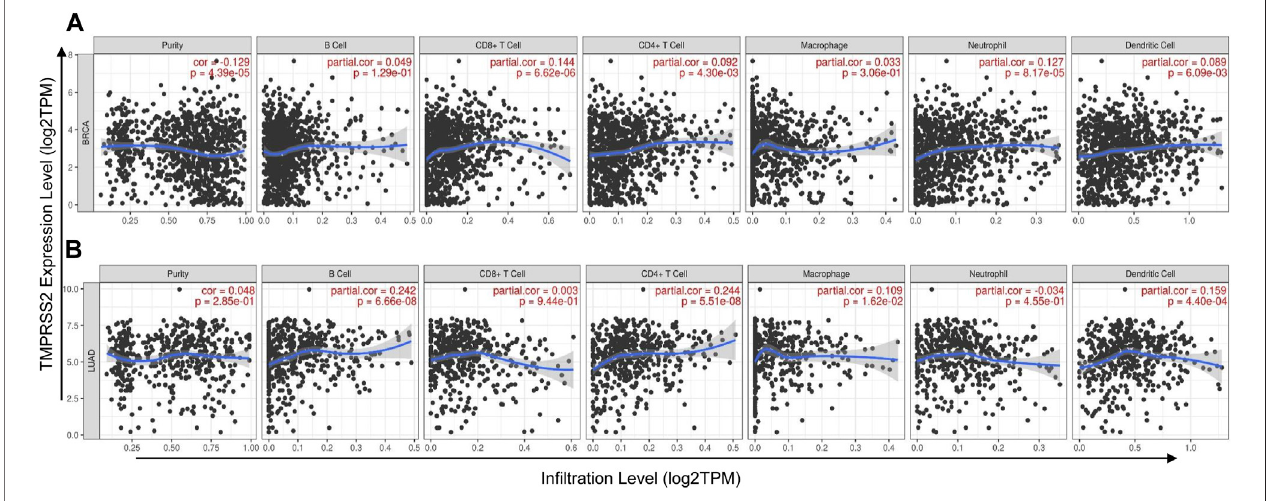
FIGURE 3 | Correlation of TMPRSS2 expression with immune cells in fi ltration level in BRCA (breast invasive carcinoma) and LUAD (lung adenocarcinoma) were detected by TIMER. (A) TMPRSS2 expression is positively correlated with in fi ltrating levels of CD8 + T cells, CD4 + T cells, neutrophils, and dendritic cells in BRCA. (B) TMPRSS2 expression is positively correlated with in fi ltrating levels of B cells, CD4 + T cells, macrophages, and dendritic cells in